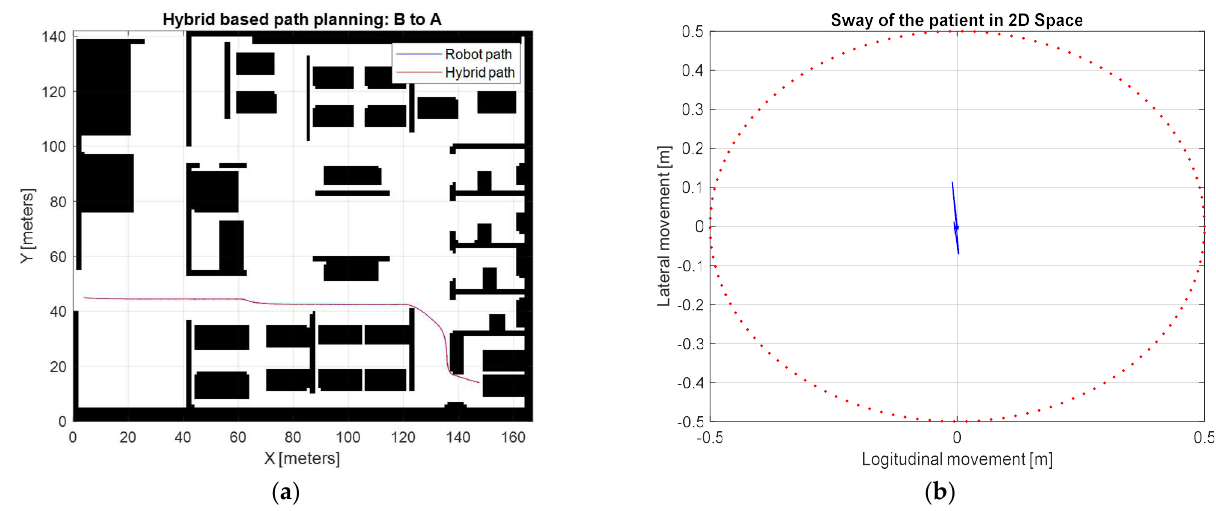
Figure 19. Motion control performance. ( a ) Reference path tracking performance. ( b ) Sway reduction performance in 2D space.